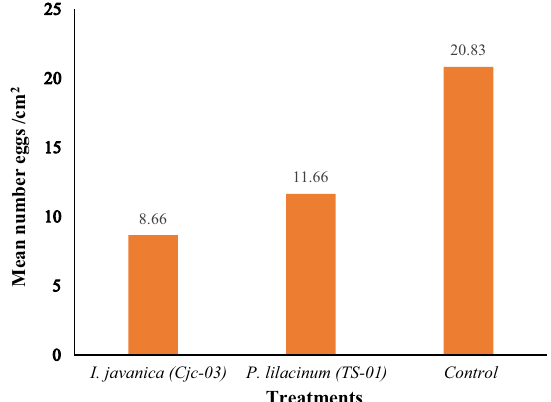
Fig. 9 Mean numbers ( SE) of Bemisia tabaci eggs on tomato leaves ± when infected with Isaria javanica and Purpureocillium lilacinum at 3 DAT